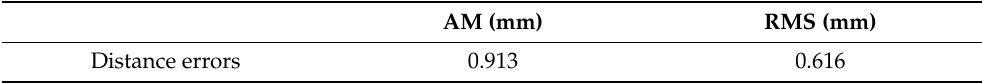
Table 5. Distance errors in each pair of aligned sets of points.